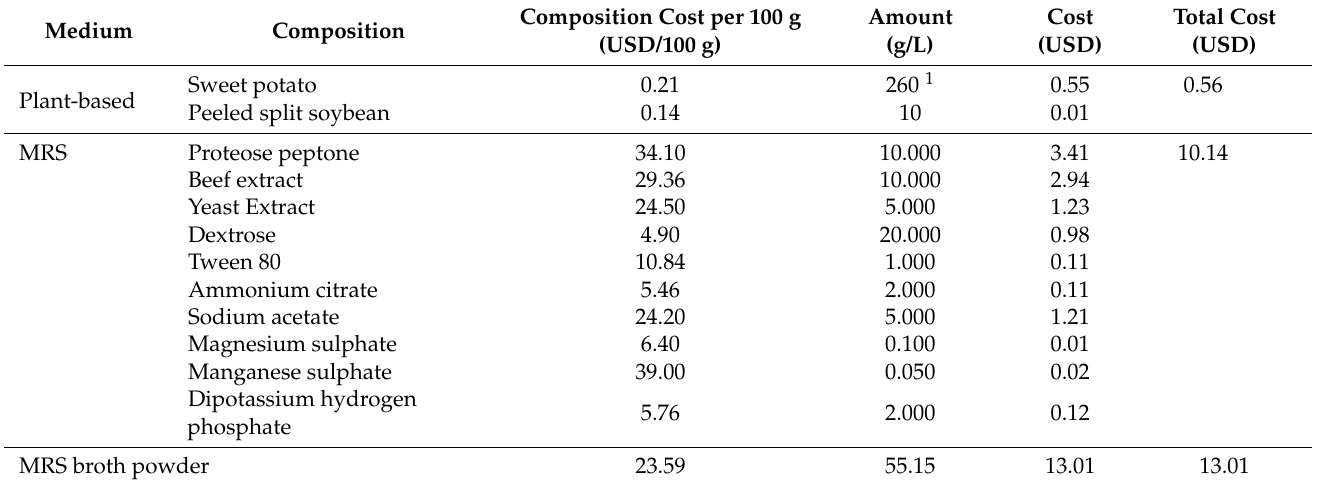
Table 5. Cost calculation of plant-based and MRS media 2